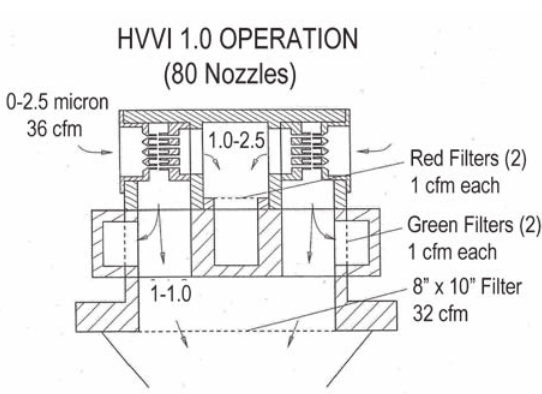
Fig. 4 Schematic of 2.5 µm HVVI.